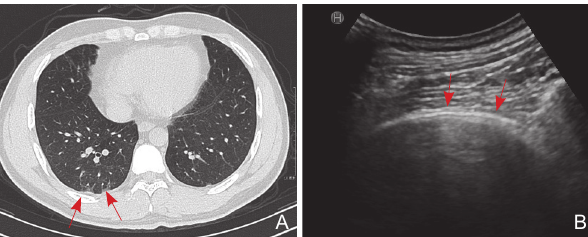
A Figure 4 This 30-year-old male patient had fever and cough for 1 day. (A) Chest CT shows small patchy opacities (arrow) in the right subpleural area deep to the rib. (B) Lung US in the corresponding location reveals normal pleural line (arrow). The lesion might be obscured by coastal rib.